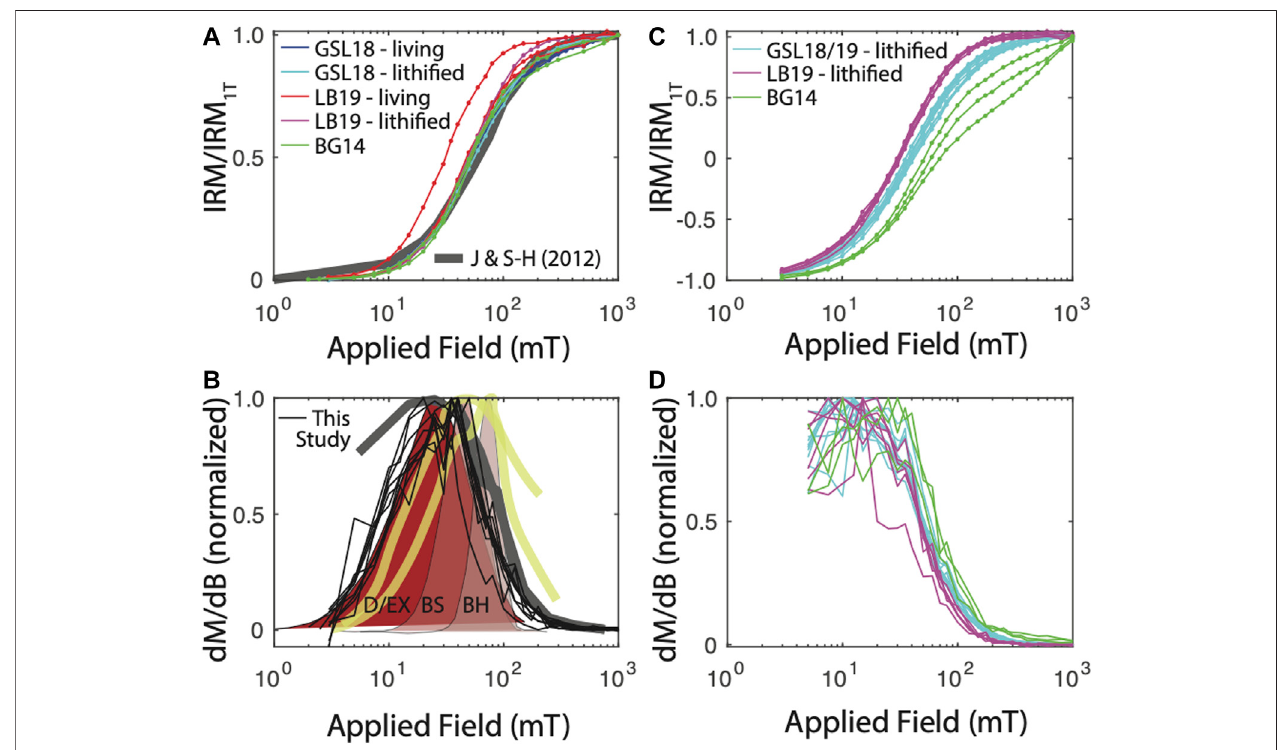
FIGURE 3 | IRM acquisition results. (A) IRM acquisition starting from the AF-demagnetized state. For comparison, IRM acquisition curves for two remagnetized carbonatesareshown(JacksonandSwanson-Hysell,2012). (B) DerivativeofIRMacquisition,normalizedtopeakvaluetobettercomparespectra.Datafrom (A) shown in thin black lines. For comparison, data from Jackson and Swanson-Hysell (2012) in thick gray line. Surface carbonate platform muds in thick yellow lines (Maloof et al., 2007). Biogenic hard (BH), biogenic soft (BS), and detrital + extracellular (D/EX) shown in shaded brown from Egli (2004). Maloof et al. (2007) and Egli (2004) distributions derived from AF demagnetization of a 300 – 350 mT IRM and are therefore not strictly analagous to data from this study. (C) Back fi eld IRM acquisition and (D) derivative.